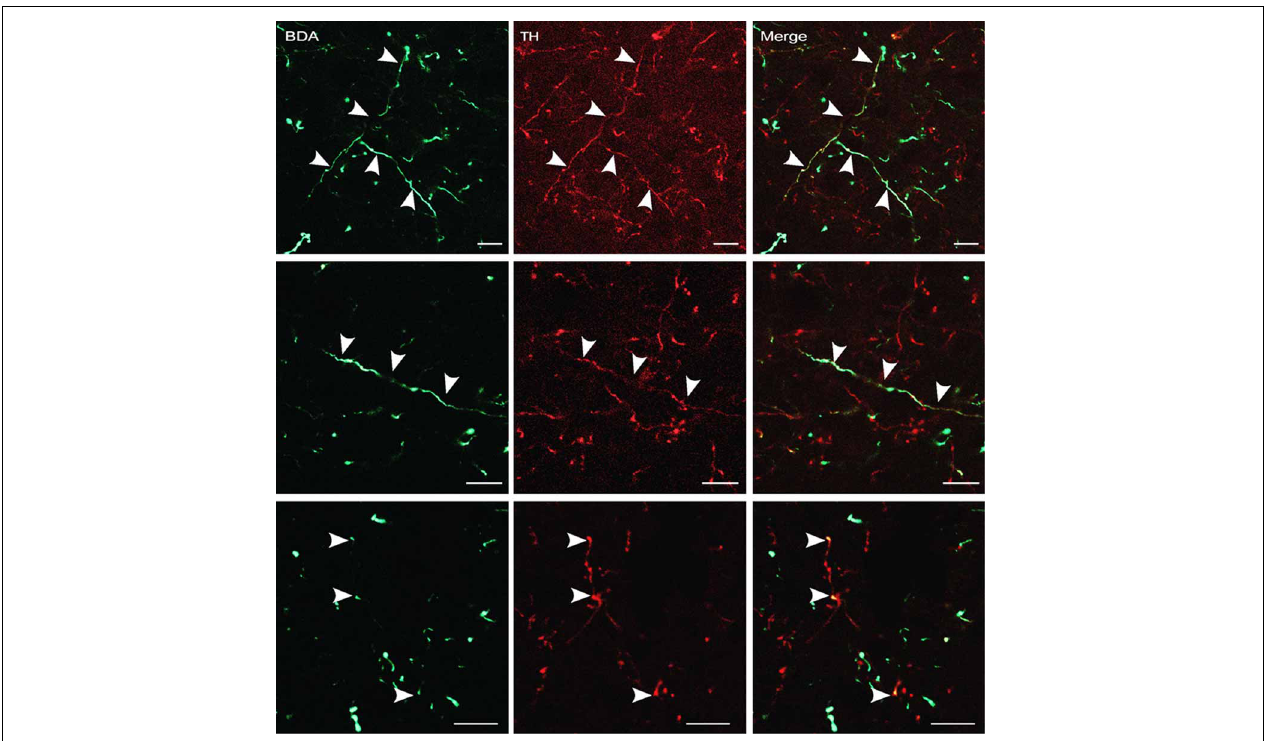
FIGURE 7 | BDA-labeled terminals and terminal boutons in the dlPAG originating from the A13 dopaminergic cell group. Upper panel: images from confocal microscopy showing BDA- (in green) and TH-labeled fibers (in